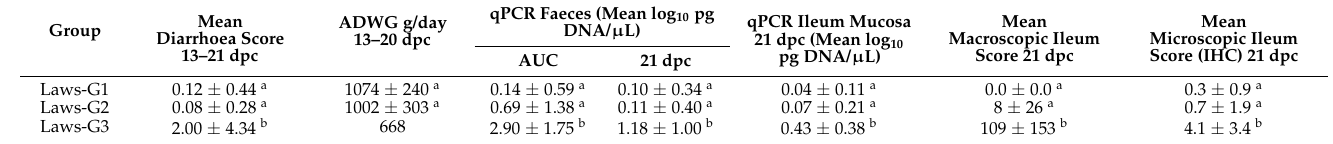
Figure 3. Antibody response to LI in ELISA. (V) Indicates time of vaccination. Arrow indicates challenge. Error bars show standard deviation. Table 3. Post- LI challenge results (mean +/ − standard deviation) .